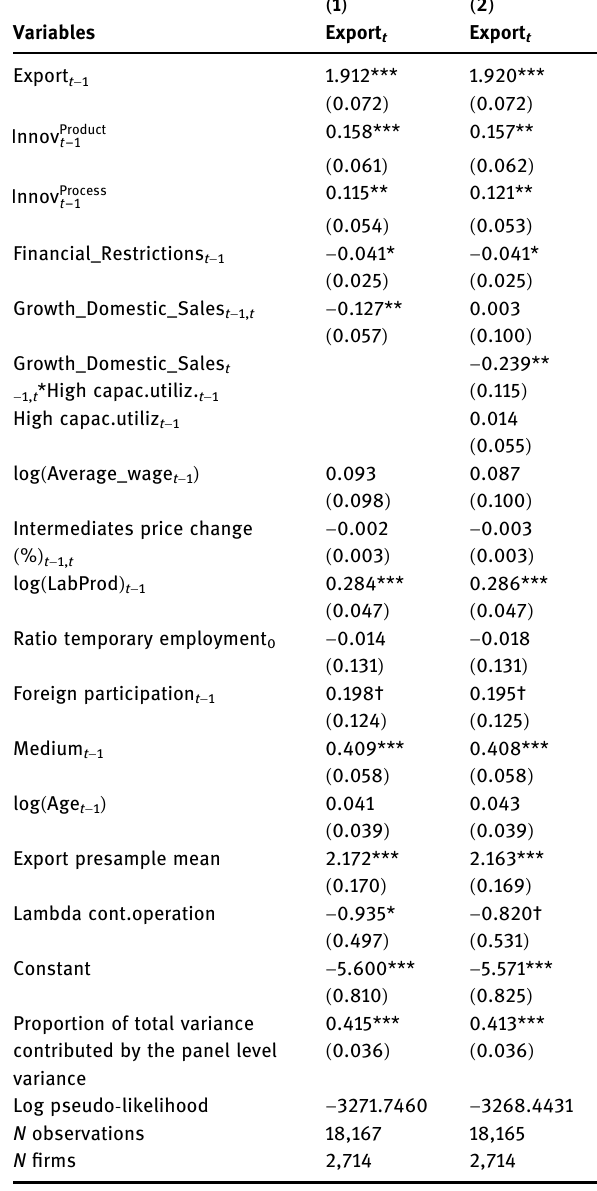
Table 5: Panel probit estimates for SMEs export